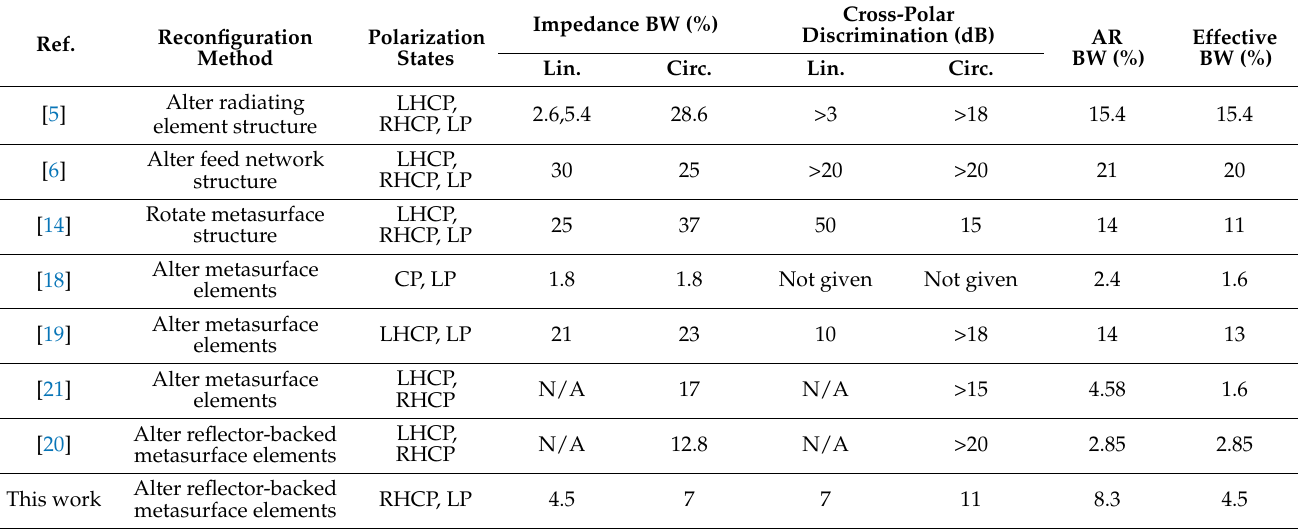
Table 2. Comparison of antennas with reconfigurable